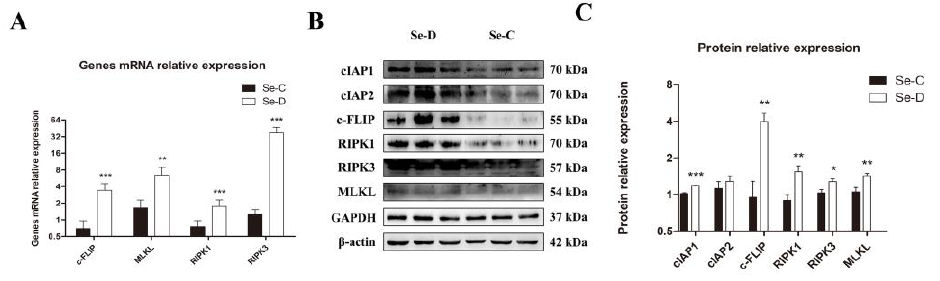
Figure 6. The mRNA ( A ) and their protein levels ( B , C ) of necroptosis-related genes are examined by RT-qPCR and WB, respectively. The mean ± SD is used to present the data above, n = 5 calves per group (except for WB n = 3). * p < 0.05, ** p < 0.01, *** p < 0.001.